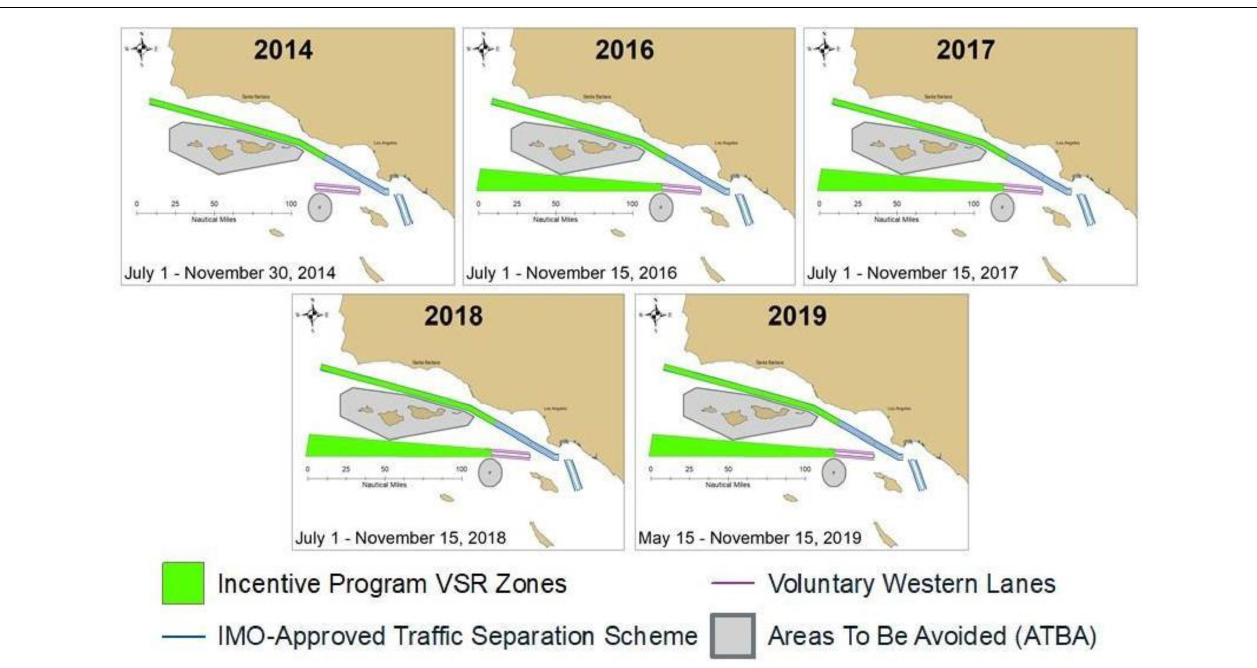
FIGURE 3 | Southern California Protecting Blue Whales and Blue Skies Program VSR zones 2014, 2016–2019, shown in